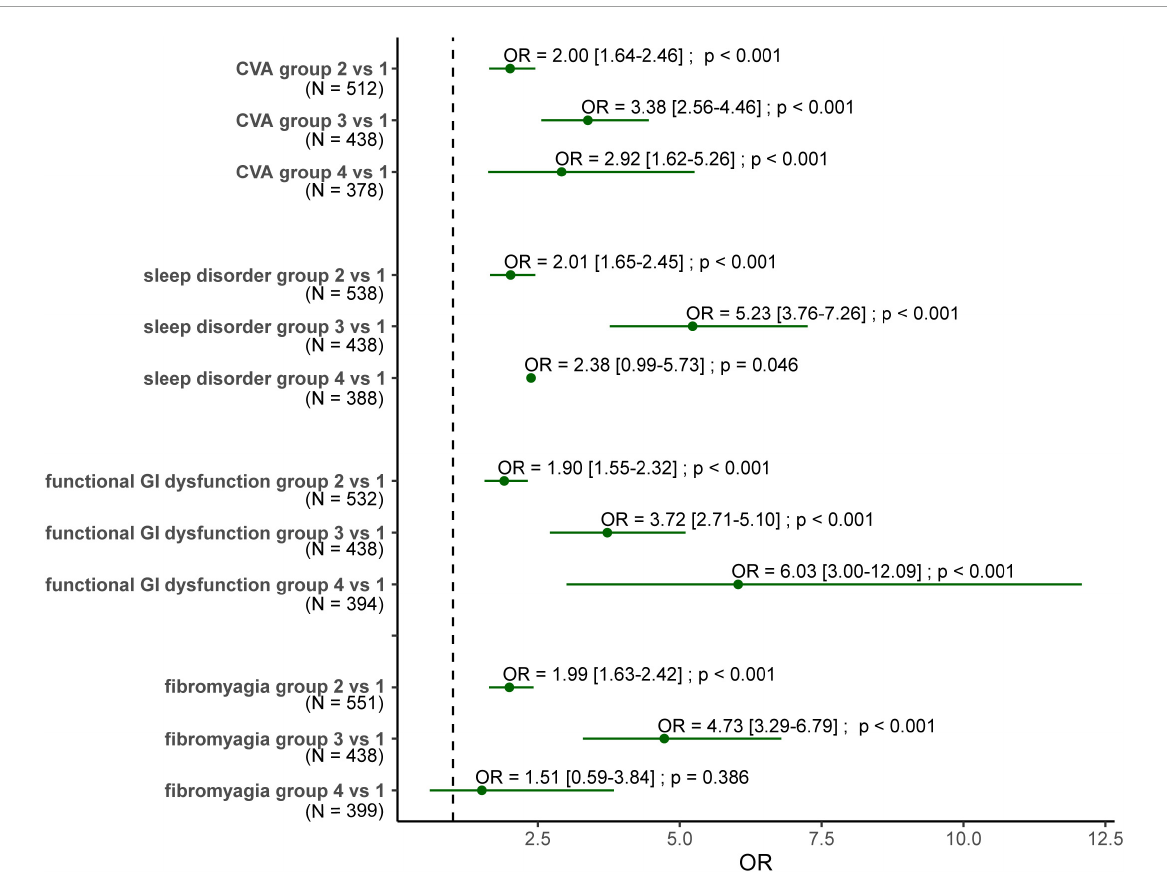
FIGURE1 Forest plot for the odds ratio of dementia for subjects carrying ε 4 allele with/without comorbidities. Group 1: subjects without the ε 4 allele nor the comorbidity. Group 2: subjects carrying the ε 4 allele without the comorbidity. Group 3: subjects carrying the comorbidity without the ε 4 allele. Group 4: subjects carrying both the ε 4 allele and the comorbidity. OR, odds ratio; N, the number of the demented cased of these two groups. The numbers within the square brackets are confidence